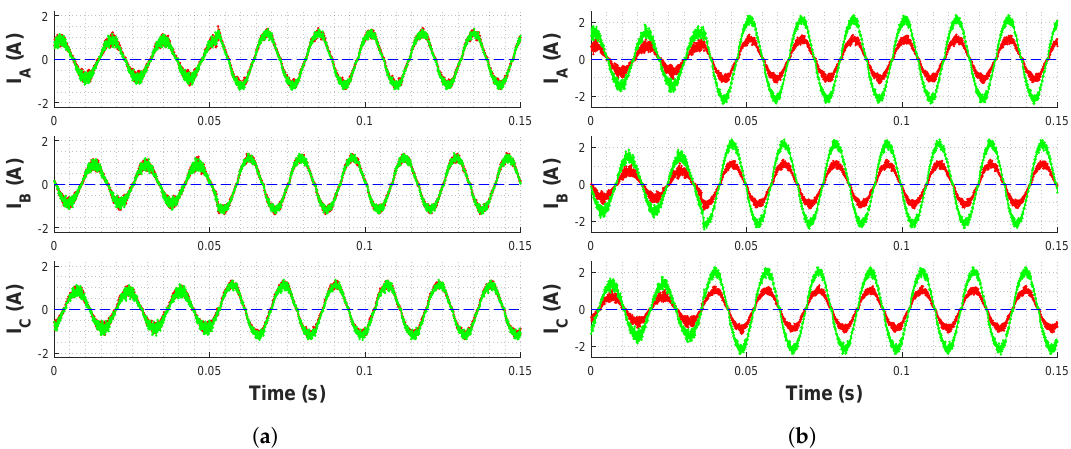
Figure 14. Hardware testing of two synchronized current-controlled inverters, with both equal and unequal load-sharing, that maintain their behavior through a step increase in load. Load resistance changes from 2.2 Ω to 0.733 Ω [20]. ( a ) Inverters with equal power sharing. ( b ) Inverters with unequal power sharing.